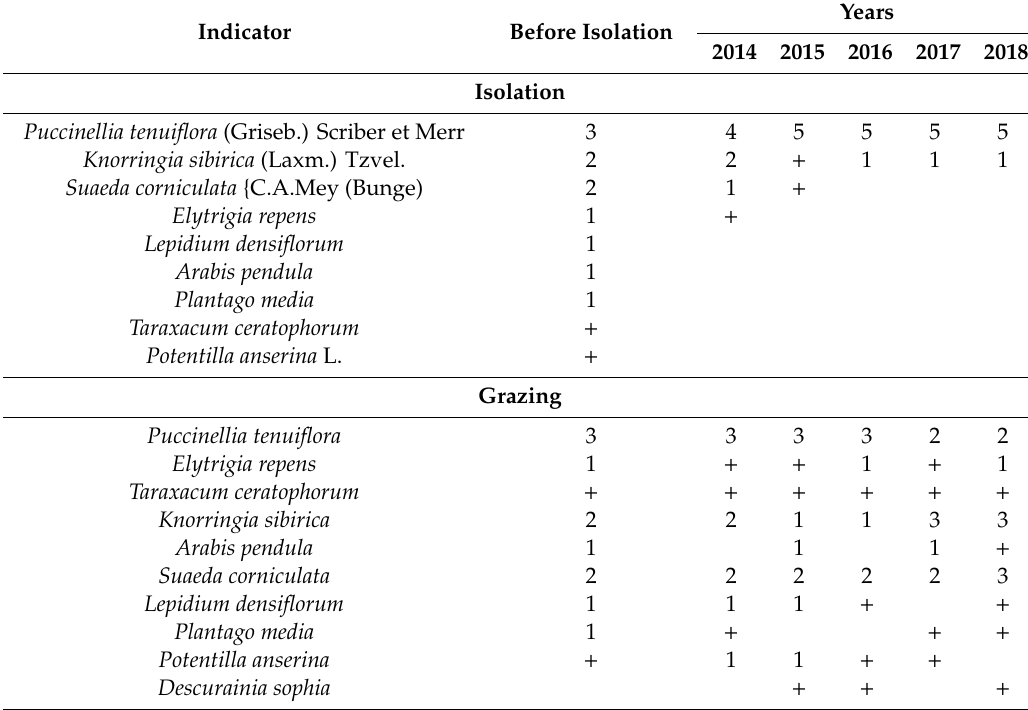
Table 2. Dynamics of the species composition of the community of the middle zone. Indicator Before Isolation